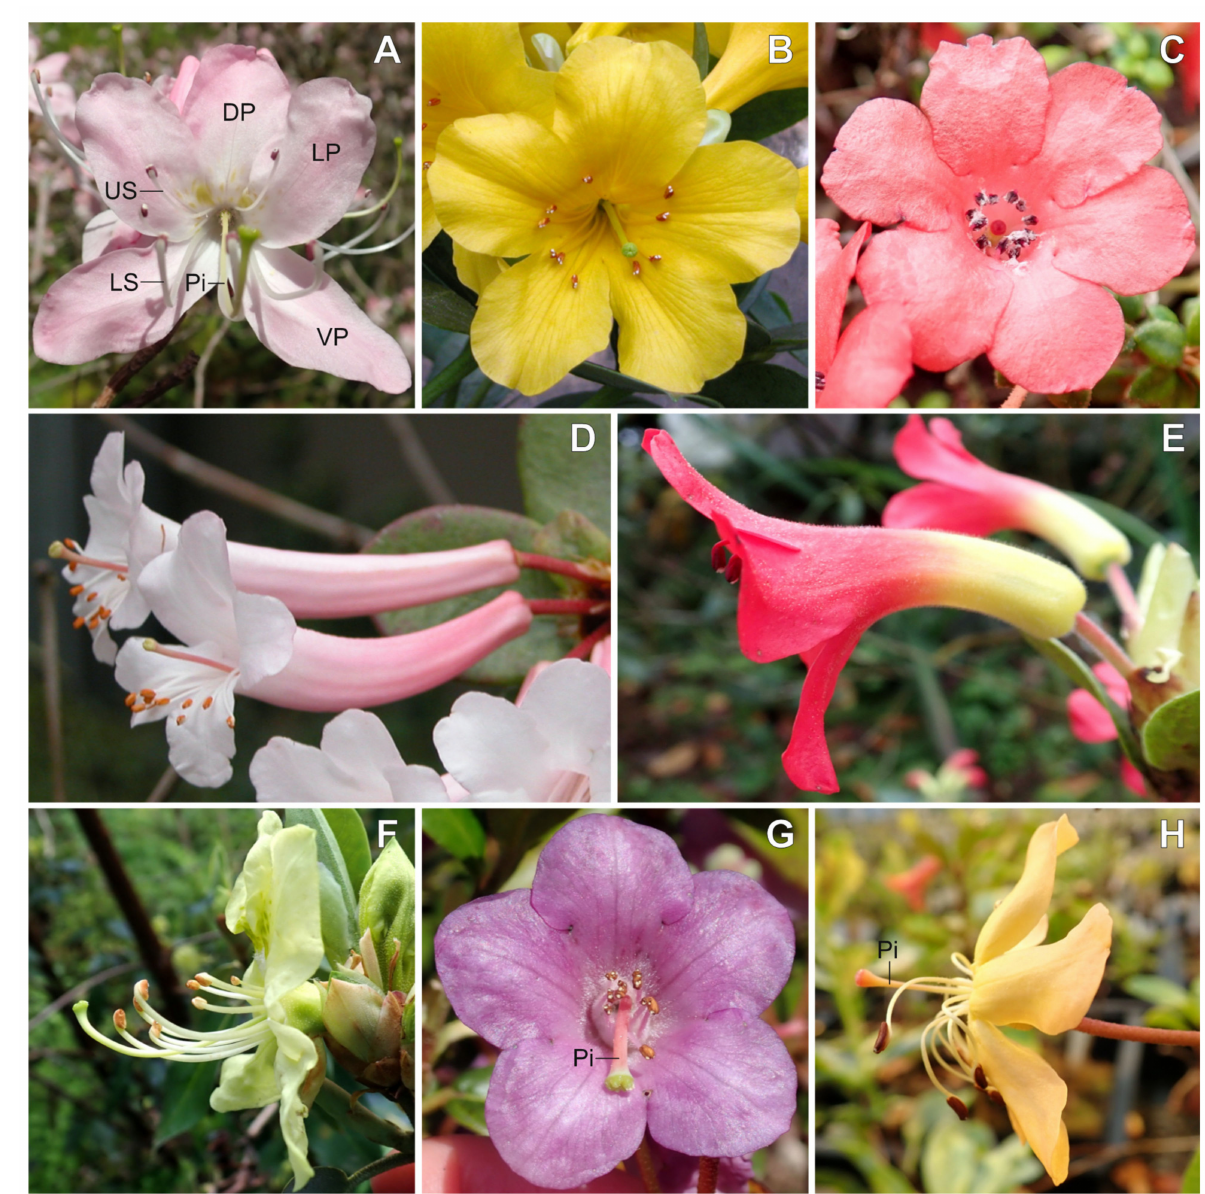
Figure 1. Flower symmetry variation across Rhododendron (Ericaceae). ( A ) Bilateral corolla symmetry and abaxially curved stamens and style in R. vaseyi A. Gray, with five petals, as is typical for the genus. ( B ) Radial corolla symmetry in R. laetum J.J.Sm. ( C ) Radial corolla symmetry due to merosity change (six petals) and dimorphic stamen length in R. rubineiflorum Craven. ( D ) Abaxially curved corolla tube in R. tuba . ( E ) Adaxially curved corolla tube in R. christi F.Först. ( F ) Lower stamens longer than upper stamens and abaxially curved stamens and style in R. triflorum Hook. f. var. bauhiniiflorum (Watt ex Hutch.) Cullen in Cullen and D. F. Chamb. ( G ) Radial corolla symmetry and adaxially curved style in R. charitopes Balf. f. and Farrer subsp. tsangpoense (Kingdon-Ward) Cullen. ( H ) Straight style in R. macgregoriae F.Muell. DP = dorsal petal, LP = lateral petal, VP = ventral petal, US = upper stamen, LS = lower stamen, Pi =